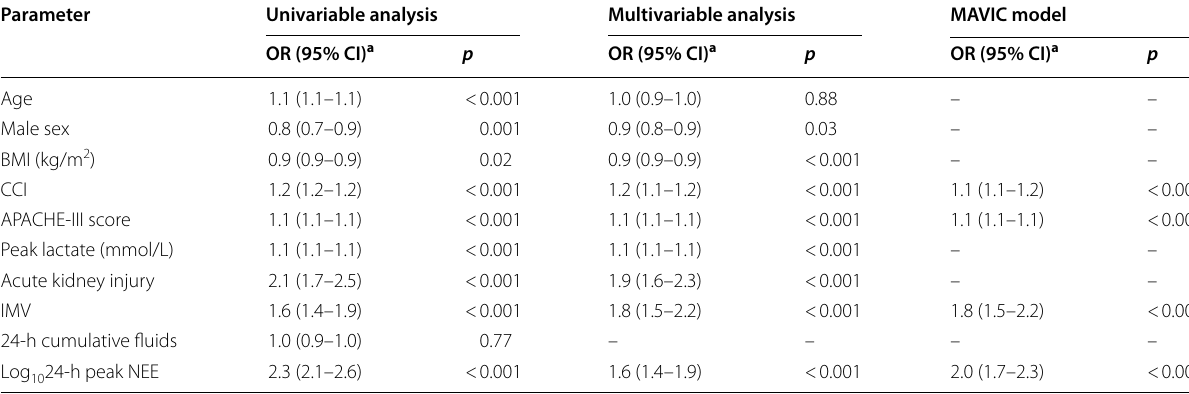
Table 3 28-day mortality predictors in the derivation cohort